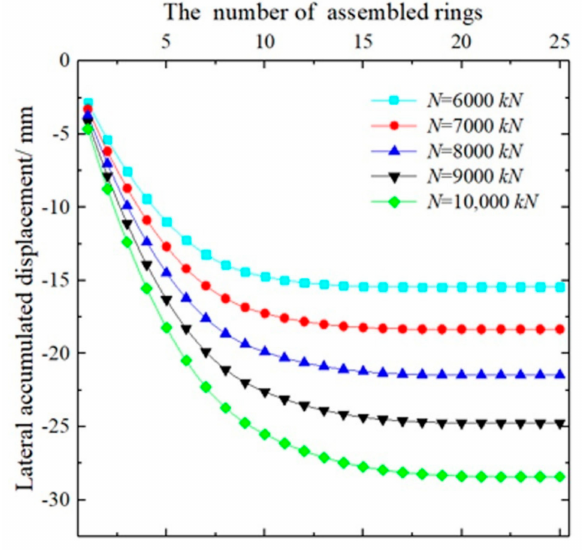
Figure 9. Lateral accumulated displacement curves of the first 20 assembled rings under di ff erent total